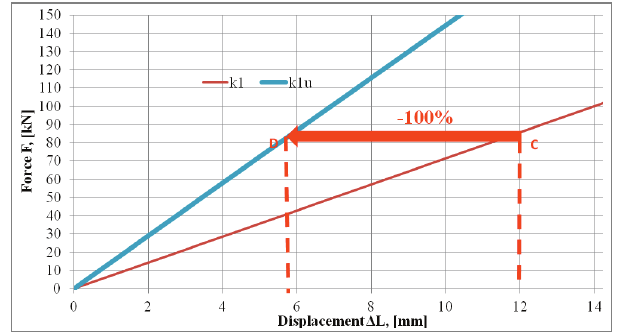
Fig. 34. Full loading characteristics for the rock bolt No. 5A